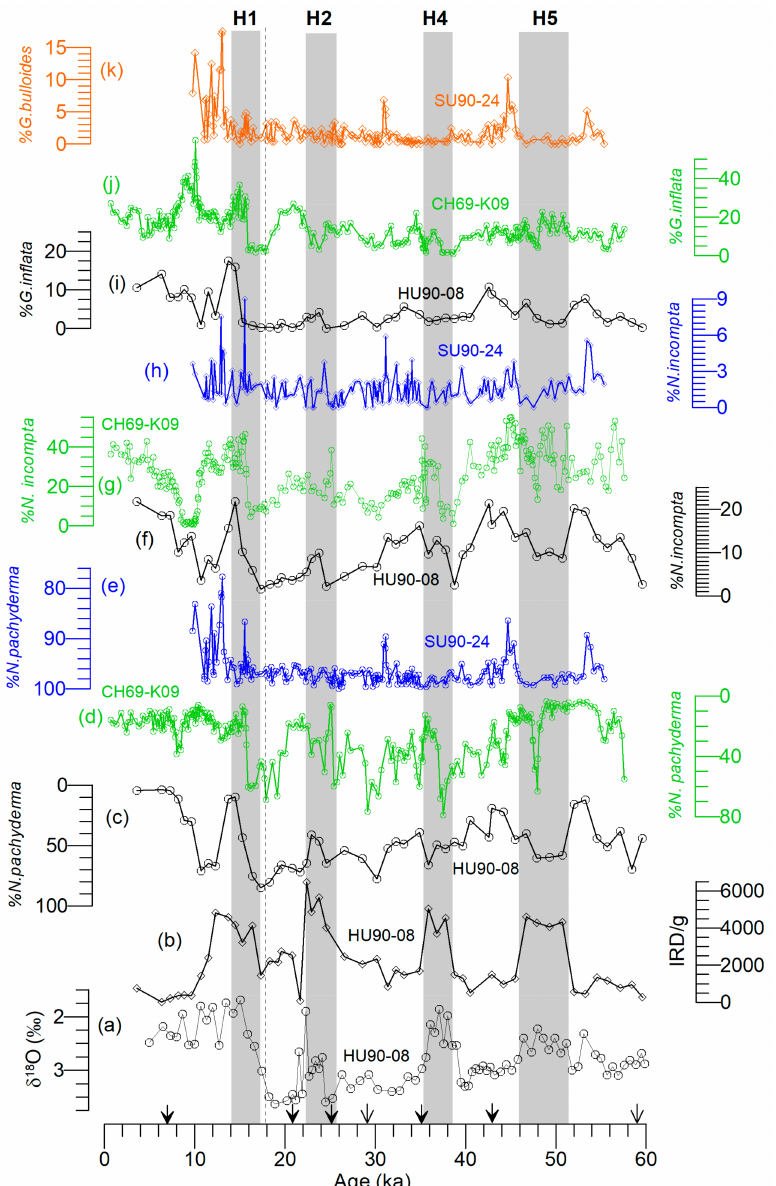
Figure 7. Proxy records of changes in the subpolar North Atlantic from cores Hu90-08 (black), CH69- K09 (green), and SU90-24 (blue) between 0 and 60 ka. ( a , b ) are the same as in Figure 5; however, % N. pachyderma ( c – e ), % N. incompta ( f – h ) and % G. inflata ( i , j ) of cores Hu90-08, CH69-K09, and SU90-24 are plotted. % G. bulloides ( k ) from core SU90-24 is independently plotted. Downward filled and unfilled headed triangles exhibit the 14 C-AMS dates and tie points, respectively, used to construct the age model of core Hu90-08 (this study). Two published records, namely SU90-24 [19] and CH69- K09 [23], were also plotted to provide an integrated assessment of the western subpolar gyre. Note the vertical discontinuous line represents the termination I (TI), whereas the Hx = Heinrich